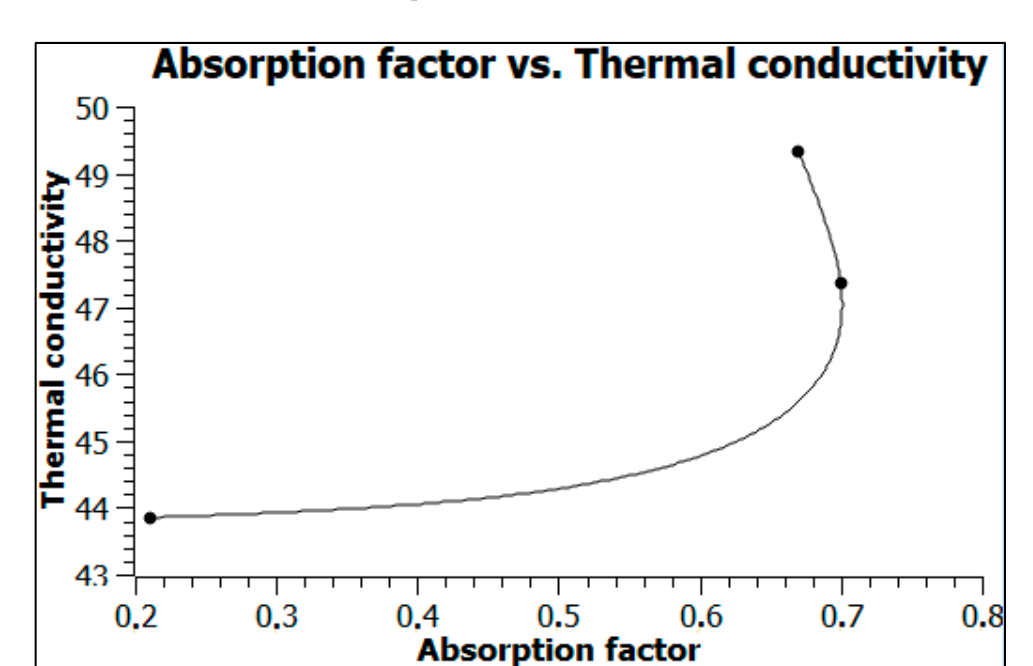
Figure 3. Thermal conductivity versus sound absorption factors of samples .